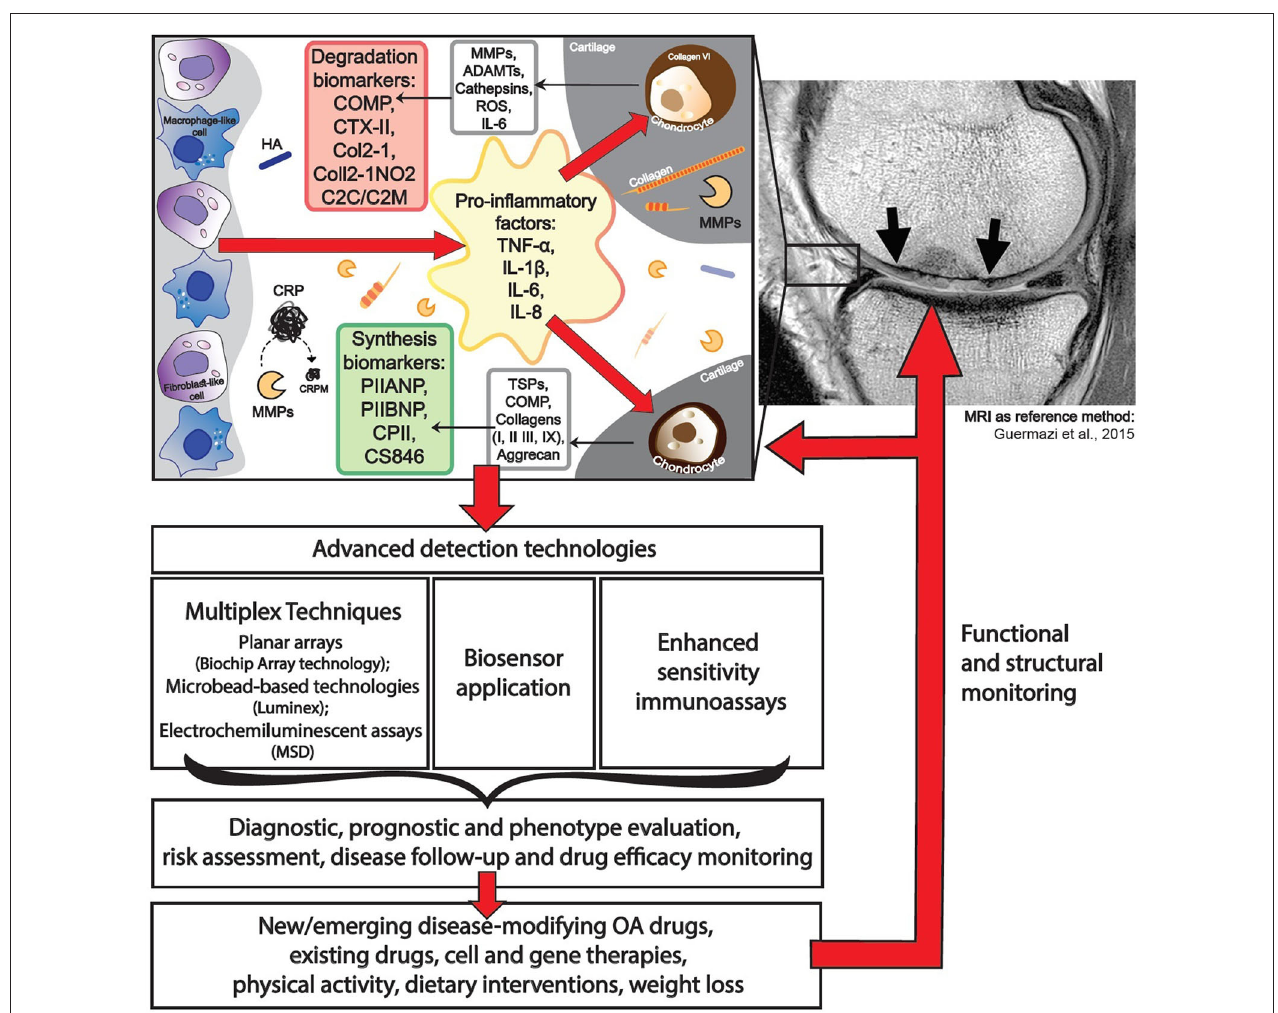
FIGURE 1 | Application of advanced technologies for immunodetection of osteoarthritis